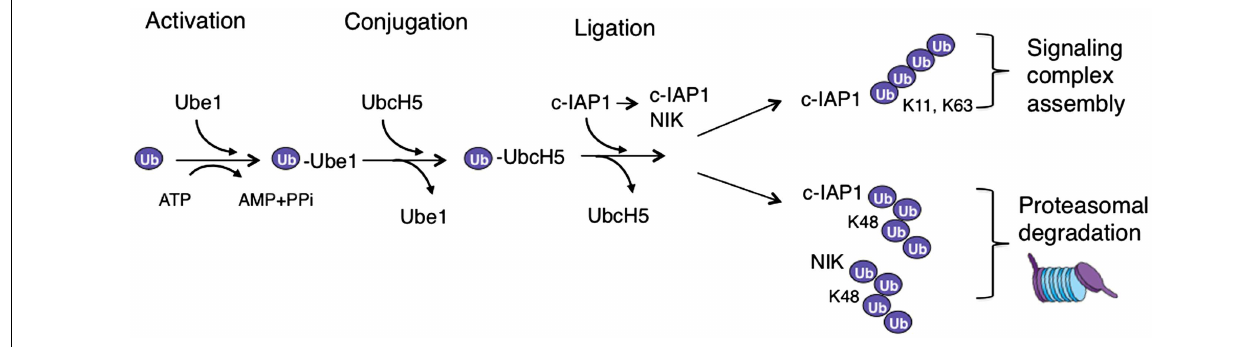
FIGURE 1 | Ubiquitination cascade inTWEAK signaling . In the activation reaction ubiquitin is transferred to an E1 enzyme (Ube1) in an ATP-dependent fashion, which leads to the transfer of activated ubiquitin to an E2 enzyme (UbcH5) in the conjugation reaction.The E2 with ubiquitin binds E3 ubiquitin ligase (c-IAP1), which can also bind a substrate – often through a different protein interaction domain – and thus allows the